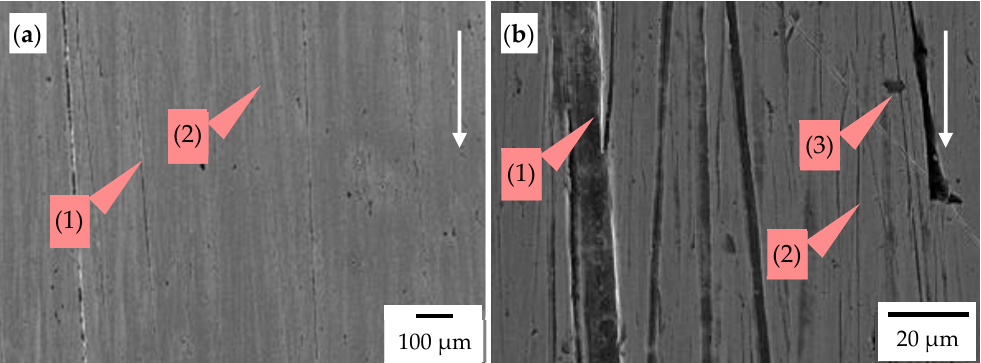
Figure 16 . The worn surface of the base material (steel) operating in the soil: chisel B, zone Z4 indi- cated in Figure 5; the white arrow presents the direction of the impact of soil. ( a ) Visible grooves (1) and scratches (2) oriented following the movement of soil particles and ( b ) visible grooves (1), scratches (2), and pinholes (3). SEM, SE detector.